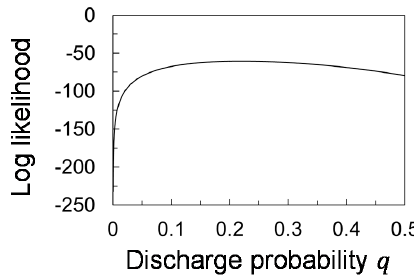
Figure 1. Log-likelihood versus discharge probability.